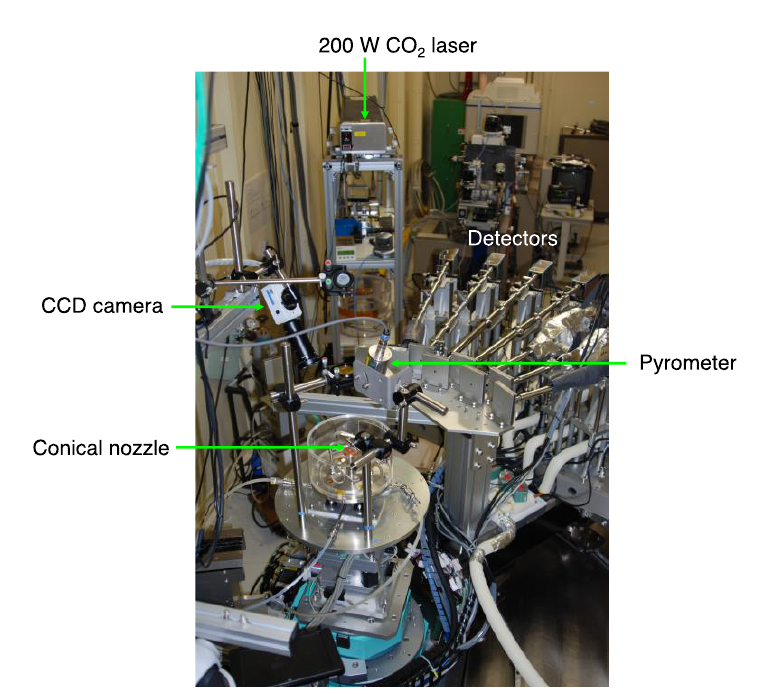
Figure 1. The beamline Conical Nozzle Levitation (CNL) apparatus installed at the BL04B2 beamline at SPring-8. CCD: charge-coupled device.